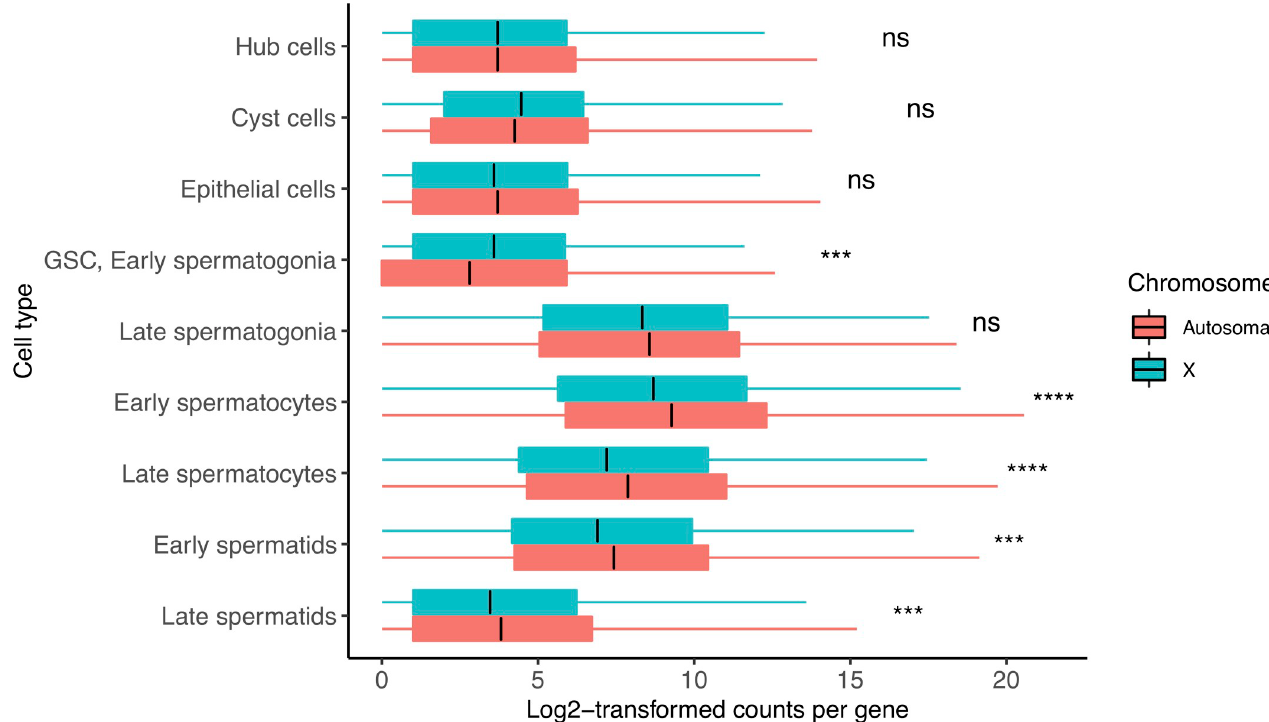
Fig 2. Dosage compensation equalizes X and autosomal transcription in select cell types. Shown is the median log-transformed (log2(counts+1) counts for every gene in X and autosomes. This ratio is similar in hub, cyst, epithelial cells, and late spermatogonia, indicating the presence of dosage compensation. GSC and early spermatogonia show a statistical enrichment of X chromosome transcription, indicating excess dosage compensation. Spermatocytes and spermatids have fewer X chromosomal than autosomal transcripts per gene, indicating that dosage compensation has been lost. This loss coincides with reduced expression of dosage compensation genes as seen in Fig 4A. Asterisks represent Holm-adjusted p values of a two-way Wilcoxon test of the null hypothesis that autosomal genes and X genes have equal detectable log-normalized counts in a cell type. In GSC, Early spermatogonia, we see a significant likelihood that the means of the two groups are not equal, and we can see that it is due to an enrichment of X chromosome counts. In meiotic cells this is the opposite- the significant value represents a depletion of X counts, since this is not a directional Wilcoxon test. Asterisks represent p values as follows: ns: > 0.05, � < 0.05, �� < 0.005, ��� < 0.0005, ���� < 0.00005. Detailed raw and adjusted p values, and interpretations of results of each cell type are in Table